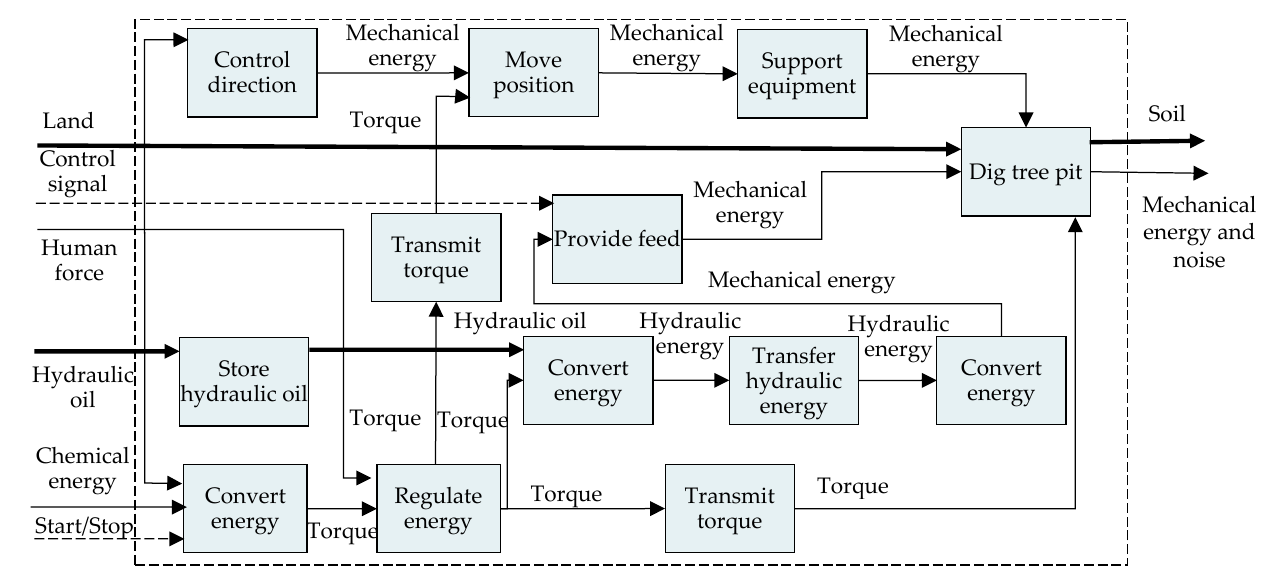
Figure 24. Functional model of the drill pole tree-planting machine.